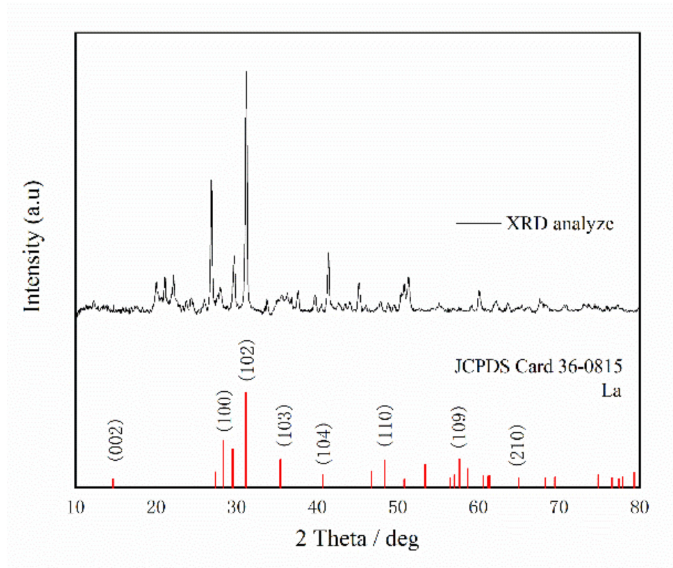
Figure 2. XRD patterns of samples.